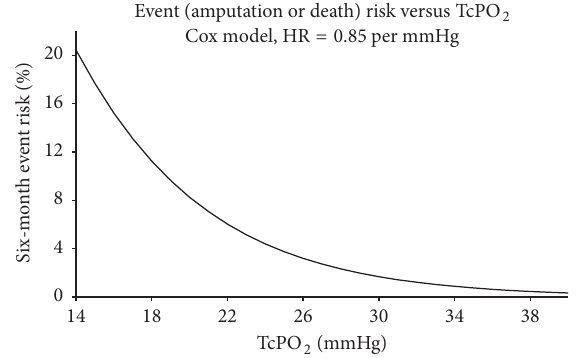
Figure 4: Correlation of risk of amputation versus TcPO 2 .